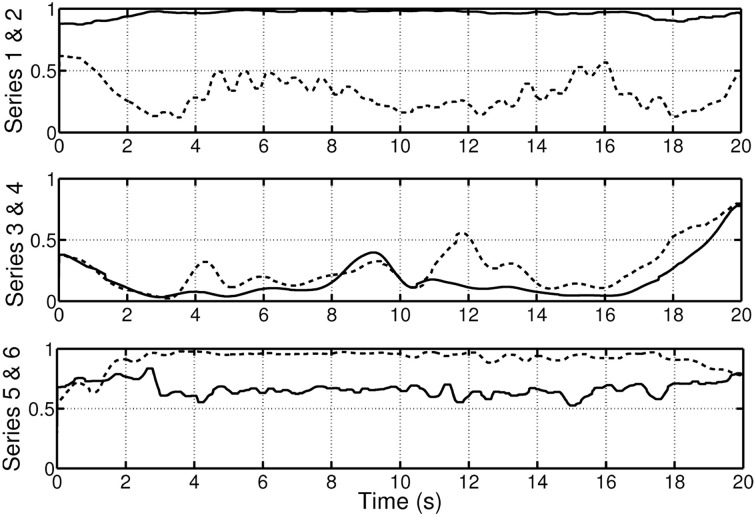
Example of the pairwise coherence measure based on the concept of delineated regions in the time-frequency plane as shown in Figure 8. Series 1 & 2 plots the coherence of the ECG and EDA signals in the pulse region (solid) and EDA region (dashed), respectively. Series 3 & 4 depict the coherence of the respiration and EDA signals in the respiration region (solid) and EDA region (dashed). Series 5 & 6 depict the coherence of the respiration and ECG signals in the pulse region (solid) and respiration region (dashed).